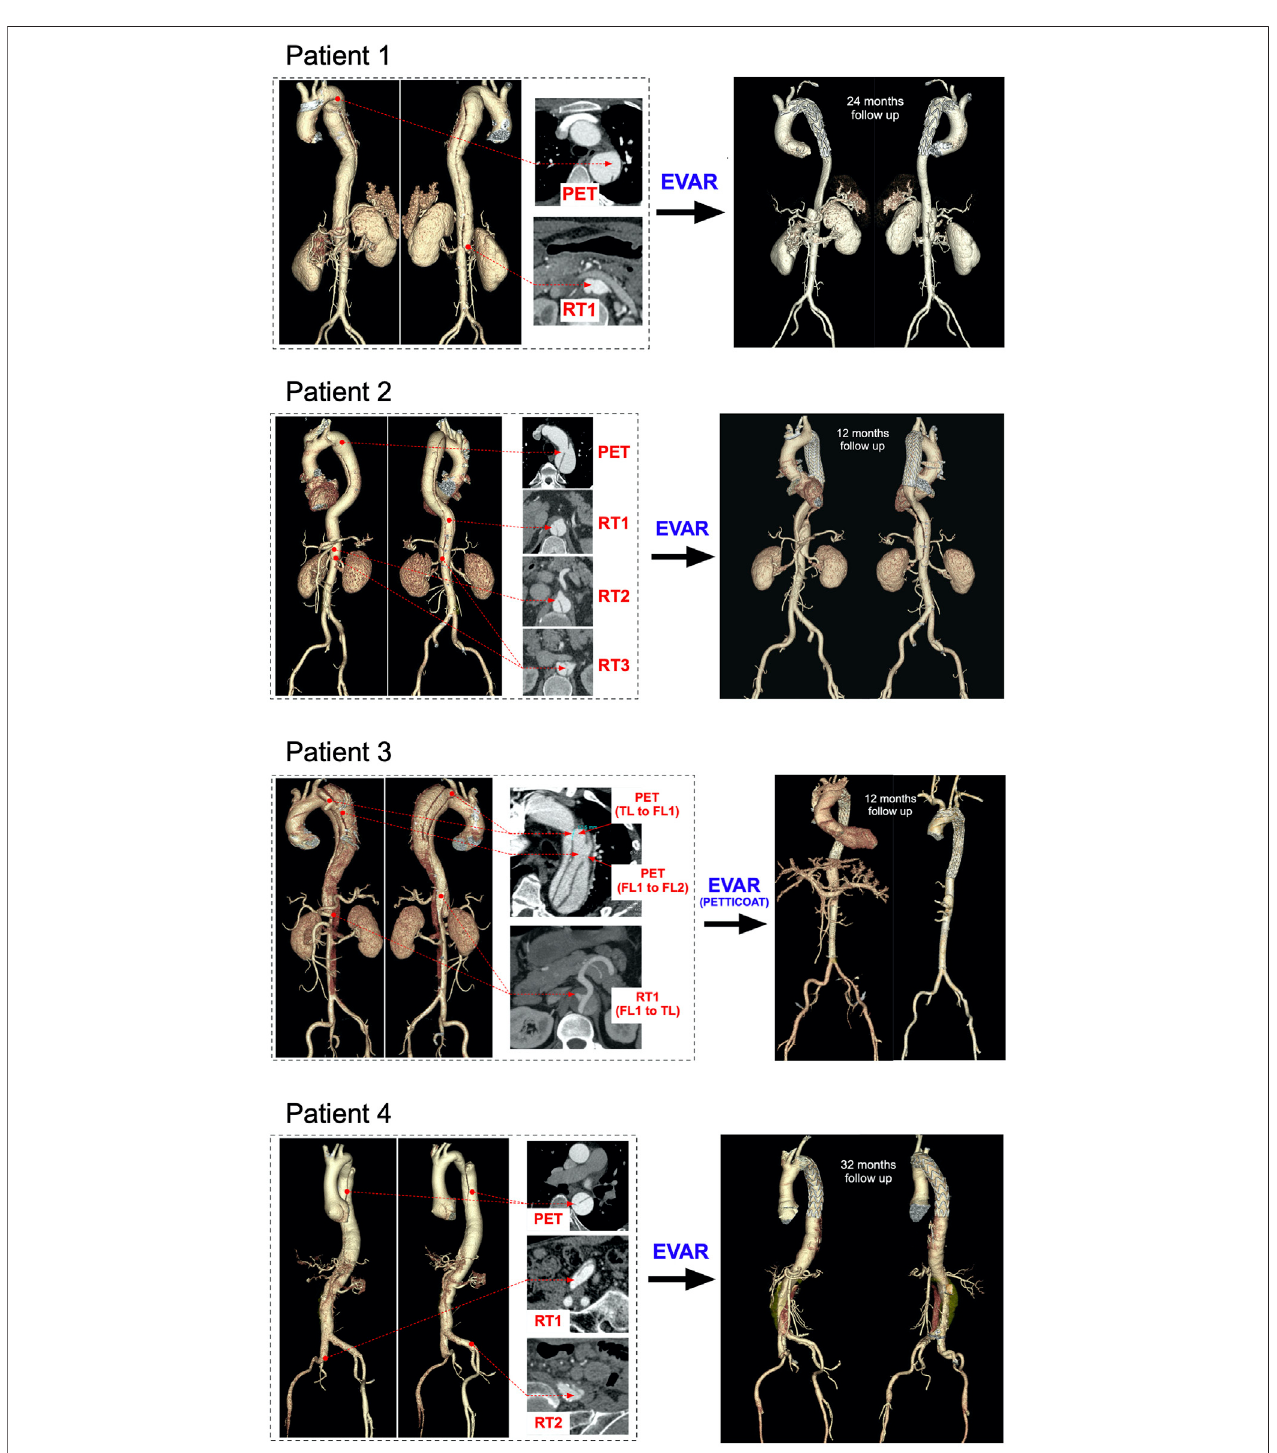
FIGURE1| Aortic reconstructions (Left) pre-TEVAR volumetricaortic reconstructions forthefourpatientswithselectedcross-sectionstopoint thevisibleprimary entry tears (PET), re-entry tears (RT), true lumens (TL) and false lumens (FL) (Right) post-TEVAR volumetric aortic reconstructions for the four patients at 12-, 24- and 32 months follow-ups, respectively.